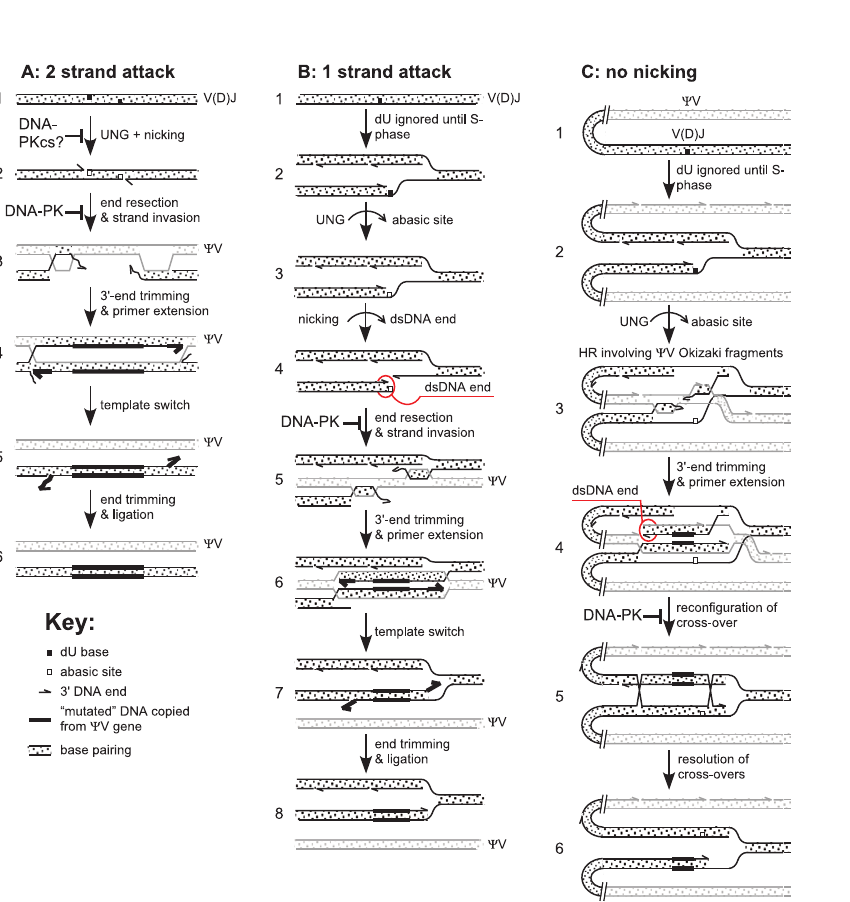
Figure 3. Models for Ig V Gene Conversion Based on Attack of Both DNA Strands by AID and Attack of One DNA Strand by AID (A) Attack of both DNA strands by AID. In step 1, two complexes containing AID attack opposed strands at the same time. If both complexes directly recruited DNA-PKcs molecules, DNA-PKcs could dimerize and perhaps inhibit base excision by UNG. In step 2, excision by UNG and a lyase or exonuclease creates a staggered DSB. Step 3 shows that gene conversion requires the production of 3 9 -protruding ends, which may involve a 5 9 –3 9 exonuclease, depending on the relative placement of the nicks. The 3 9 -protruding ends initiate gene conversion by invading a homologous W V gene. This step could be inhibited by the binding of dsDNA ends to the DNA-PK complex. In steps 4–6, nonhomologous ( ‘‘ mutated ’’ ) sequences are copied from the W V gene by mismatched end trimming, primer extension, template switch, further end trimming, and ligation. (B) Attack of one DNA strand by AID. In step 1, AID deamination in G1-phase may be ignored until S-phase, based on the model in [11]. In S-phase, shown in step 2, the dU base produced by AID is encountered by a replication fork, enabling access by UNG, which then creates an abasic site. Step 3 shows the abasic site is excised to create a dsDNA end, which can recruit the DNA-PK complex. In step 4, if DNA-PK is not recruited, the dsDNA end promotes gene conversion with an upstream W V gene. (C) Attack of one DNA strand by AID. As in (B), AID deamination is ignored until S-phase. In step 2, as in step 2 of (B), the dU base is encountered by a replication fork, but in this case lagging strand nicks (Okazaki fragments) are still present in the upstream W V genes. Step 3 shows the abasic site generated by UNG stalls the replication fork, without inducing nicking, and promotes strand invasion into an upstream W V gene. Step 4 shows a dsDNA end is created when primer extension encounters a lagging strand nick due to Okazaki fragments in the template W V gene. The replication fork stalls again. If DNA-PK binds the dsDNA end it inhibits the completion of HDR. In step 5, a second reconfiguration of the stalled replication fork occurs, and in step 6, resolution of the double cross-over completes gene conversion.